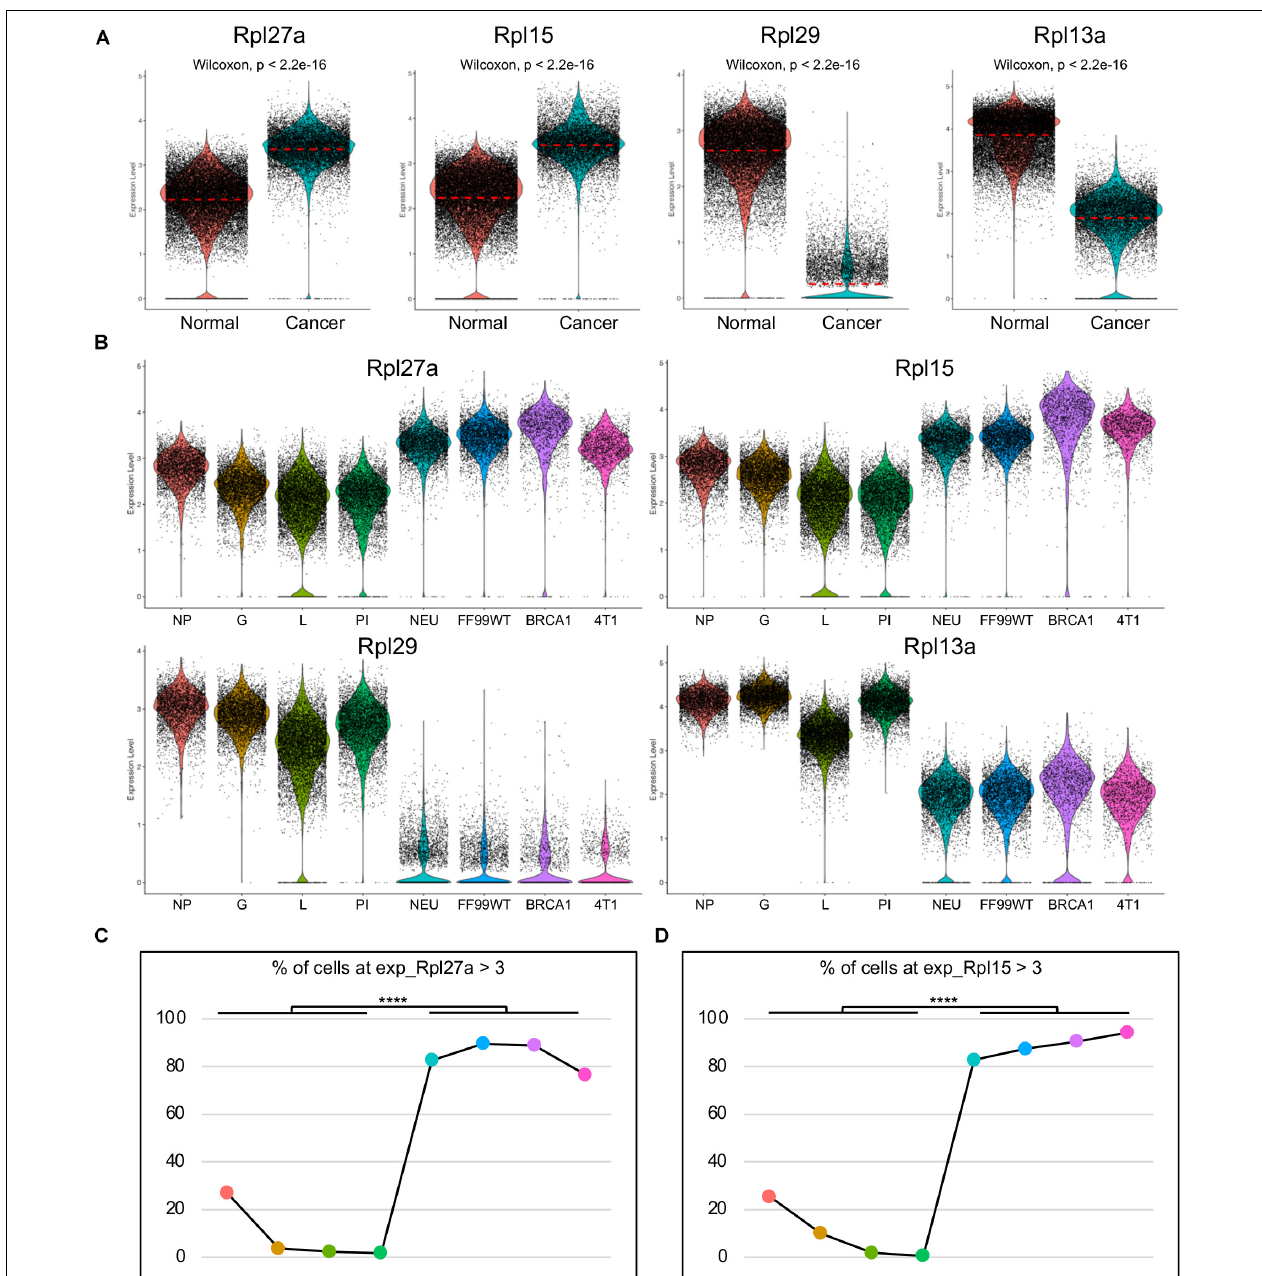
FIGURE 2 | Upregulated Rpl27a and Rpl15 in cancer cells of the mouse models. (A) Violin plots showing transcription levels of Rpl27a, Rpl15, Rpl29, and Rpl13a in normal epithelial cells and breast cancer cells. (B) Visualization of transcription levels of Rpl27a, Rpl15, Rpl29, and Rpl13a in epithelial cells of each developmental stage and breast cancer cells of each mouse model by split violin plots. (C,D) Quantification of the percentage of cells with Rpl27a > 3 (C) or Rpl15 > 3 (D) in each developmental stage and breast cancer mouse model. **** p <